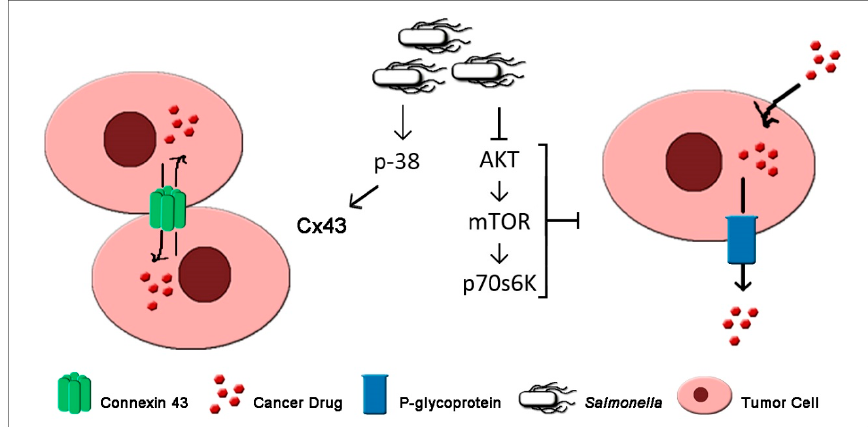
Figure 2. Salmonella enhances gap intercellular communication (GJIC) via gap junctions and alters membrane permeability to re-sensitize drug-resistant tumor cells.